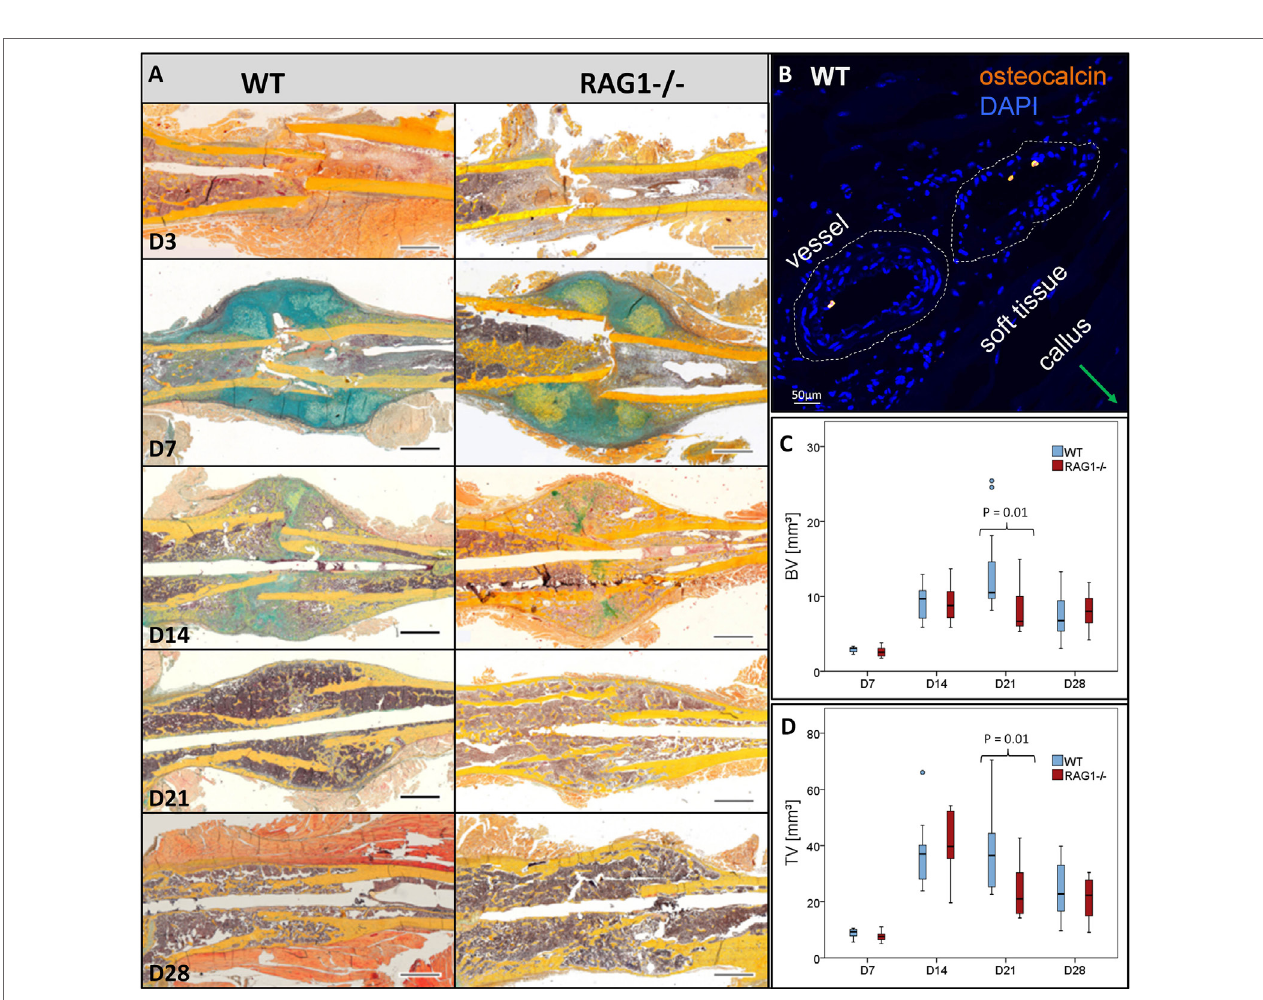
FigUre 2 | Fracture healing in wild-type (WT) and recombination activating gene 1 homozygous knockout (rag1 − / − ) animals: (a) fracture healing in the WT animals showed the typical steps of hematoma [day 3 (D3)], soft callus formation (D7), woven bone deposition (D14), and remodeling (21 and 28 days) . In the RAG1 − / − animals, lack of mature T and B cells has altered this sequence. D3 shows abundant endosteal hematoma, however, periosteal bone formation far from the fracture gap was also seen. 7 days after fracture mineralized batches in the cartilaginous callus indicated enhanced mineralization of the callus, these were more pronounced than in the WT. At D14, the cartilage was vastly calcified and remodeling was enhanced at 21 and 28 days (Movat’s pentachrome staining: bone—yellow, cartilage—blue/green, muscle—red, bone marrow—magenta, and connective tissue— light blue; scale = 1 mm). (B) Osteocalcin-positive cells were found in WT in the vessel of the soft tissue surrounding the callus. Micro computed tomography analysis (without normalization to the contralateral bone—to analyze the difference in healing only) showed higher bone volume (c) and the total volume (D) in the WT animal callus at